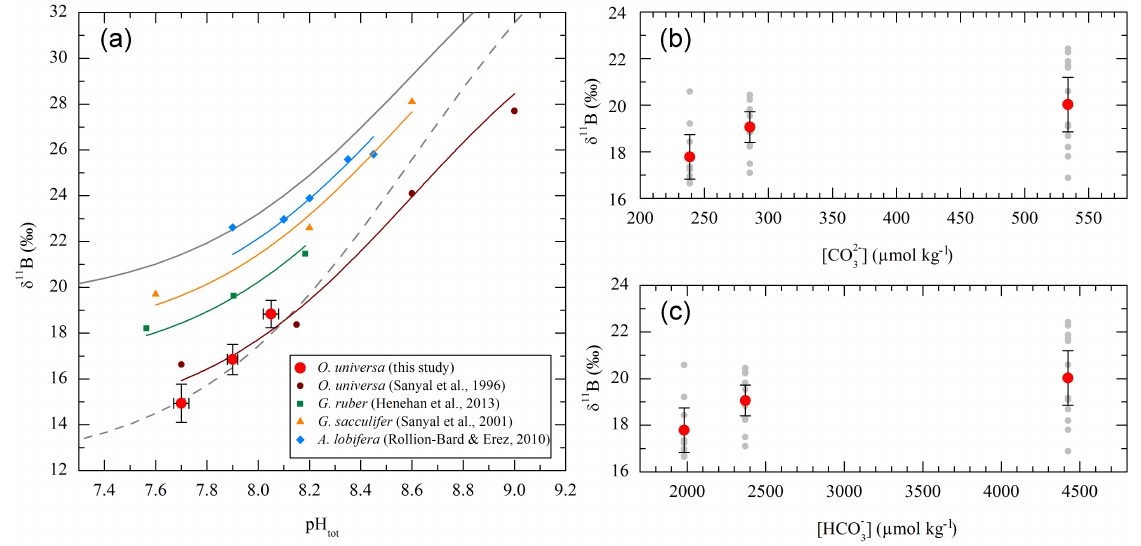
Figure 3. (a) Converted median δ 11 B of cultured O. universa calcite (red circles) error bars represent ± 2 σ errors, solid grey line shows empirical values for seawater δ 11 B borate with a fractionation factor of 11 − 10 K B = 1 . 020 (Hönisch et al., 2007) at T = 23 ◦ C and S = 38. Dashed grey line shows the experimental δ 11 B borate curve with a fractionation factor of 11 − 10 K B = 1 . 0272 (Klochko et al., 2006) at T = 23 ◦ C and S = 38. (b) Median δ 11 B cultured O. universa calcite grown at constant pH of 8.05 but varying [CO 2 − B(OH) − in cultured O. universa calcite grown at constant pH of 8.05 but varying [HCO − 4 laser ablation analyses per